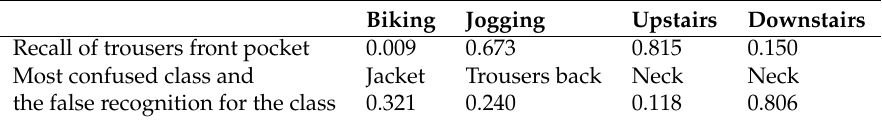
Table 13. Averaged recalls per person against the dataset obtained during various